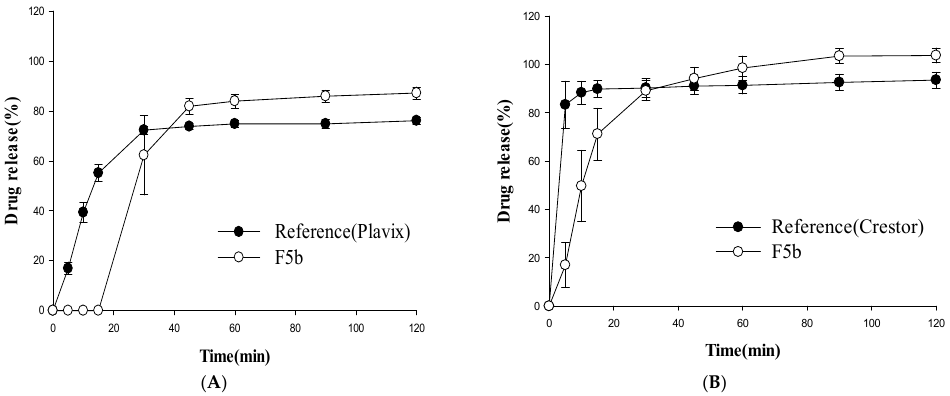
Figure 5. Dissolution profiles of clopidogrel ( A ) and rosuvastatin ( B ) from the test (F5b) and reference formulations at pH 4.0 (mean ± SD, n = 4).